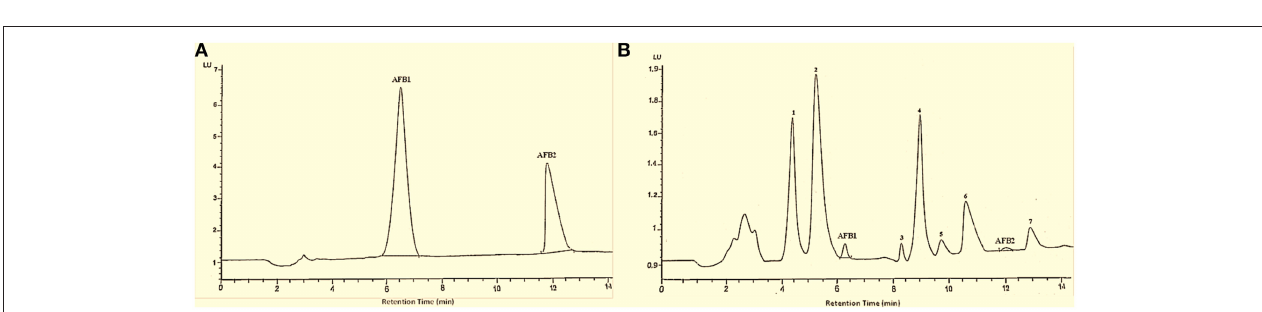
FIGURE 1 | Effect of pH on detoxification of aflatoxin by aqueous extracts of T. ammi . Whereas (A) AFB1; (B) AFB2.